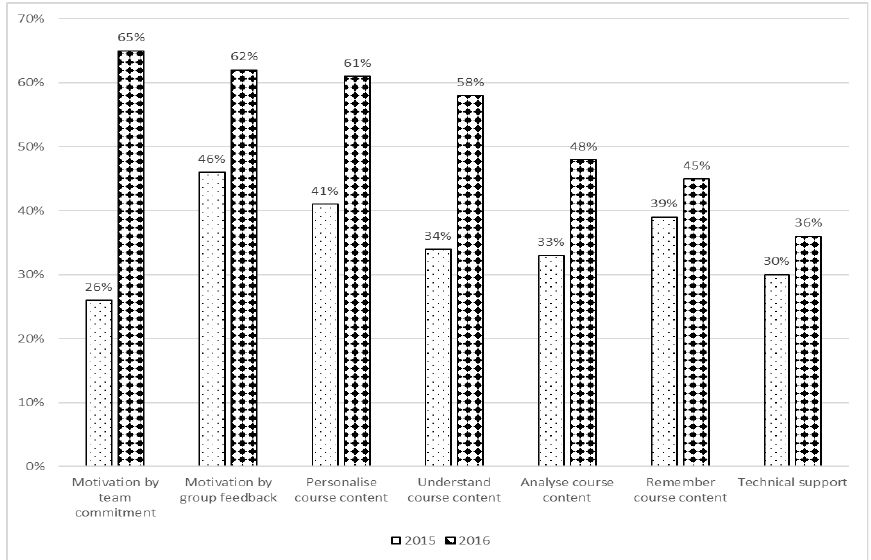
Fig. 5. What did the group help